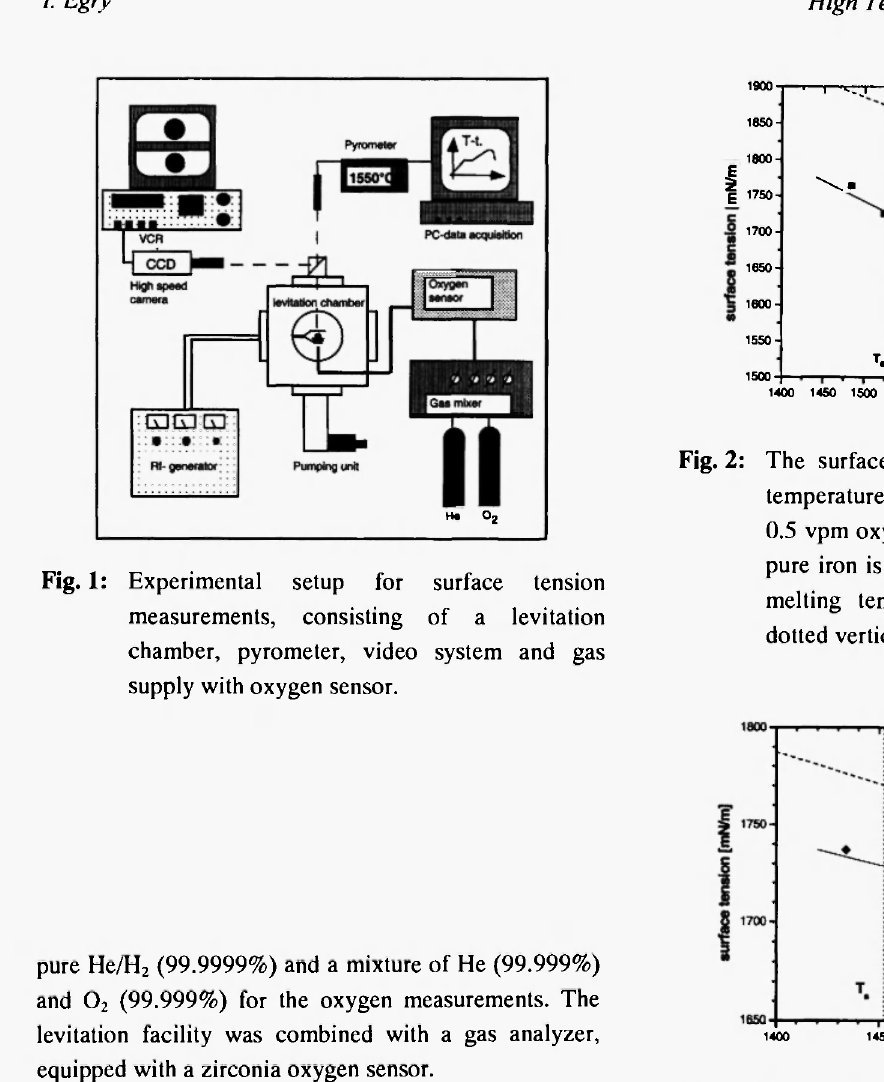
The surface tension of nickel as a function of temperature in a helium atmosphere containing 0.5 vpm oxygen. For comparison, the result for pure nickel is also shown by the dashed line. The melting temperature T s is indicated by the dotted vertical